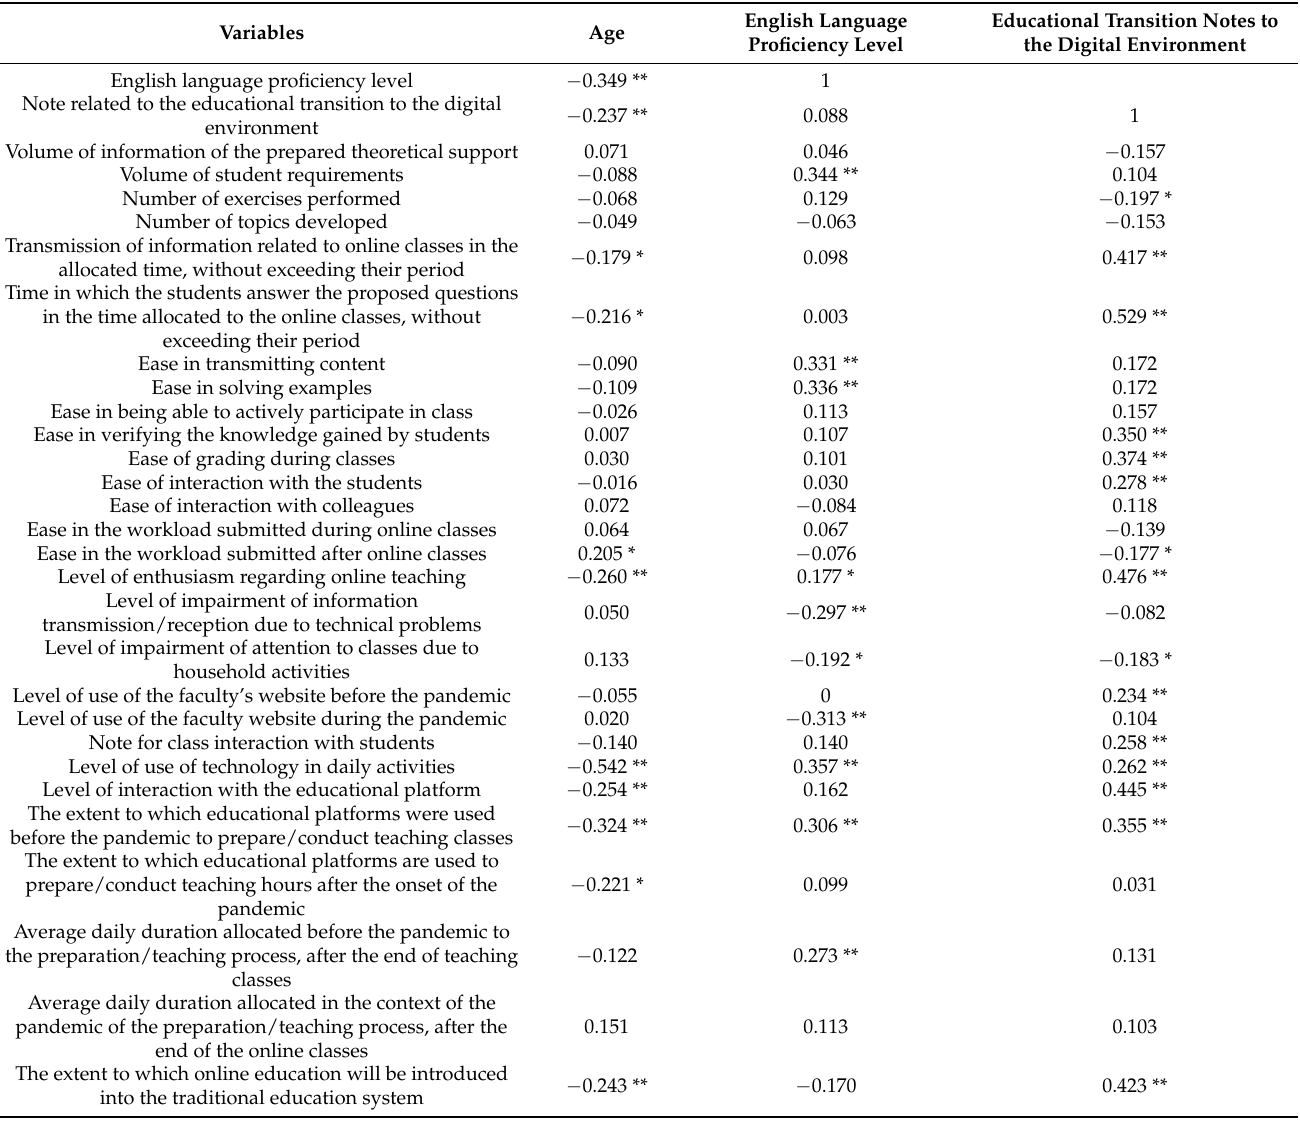
Table 15. Correlations between teachers’ age, English language proficiency level, educational transi- tion note to the digital environment, and other